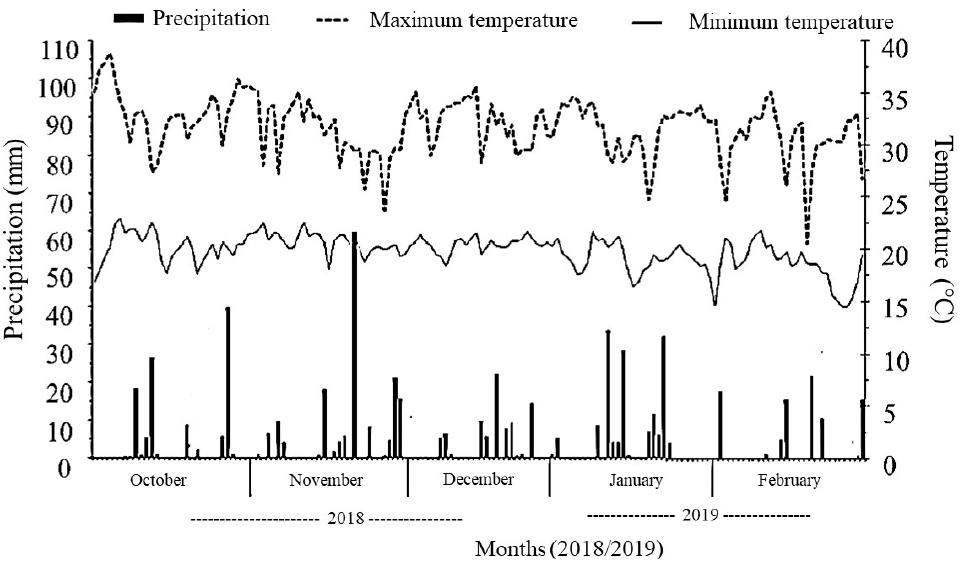
Figure 1. Precipitation and temperature (maximum and minimum) during October to February (2018/2019 harvest), in Ribeirão Bonito, São Paulo, Brazil. The experimental design was randomized complete blocks, with four replications. Table 1. Soil and physical characterization before installing the experiment at depths ranging from 0 to 0.50 m, and fertilizer characterization.